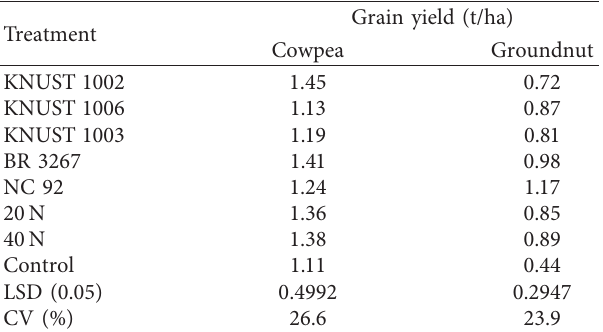
Table 4: Effects of different rhizobial strains and N fertilizer ap- plication on grain yields of cowpea and groundnut grown at Nyankpala in the Guinea Savanna zone of